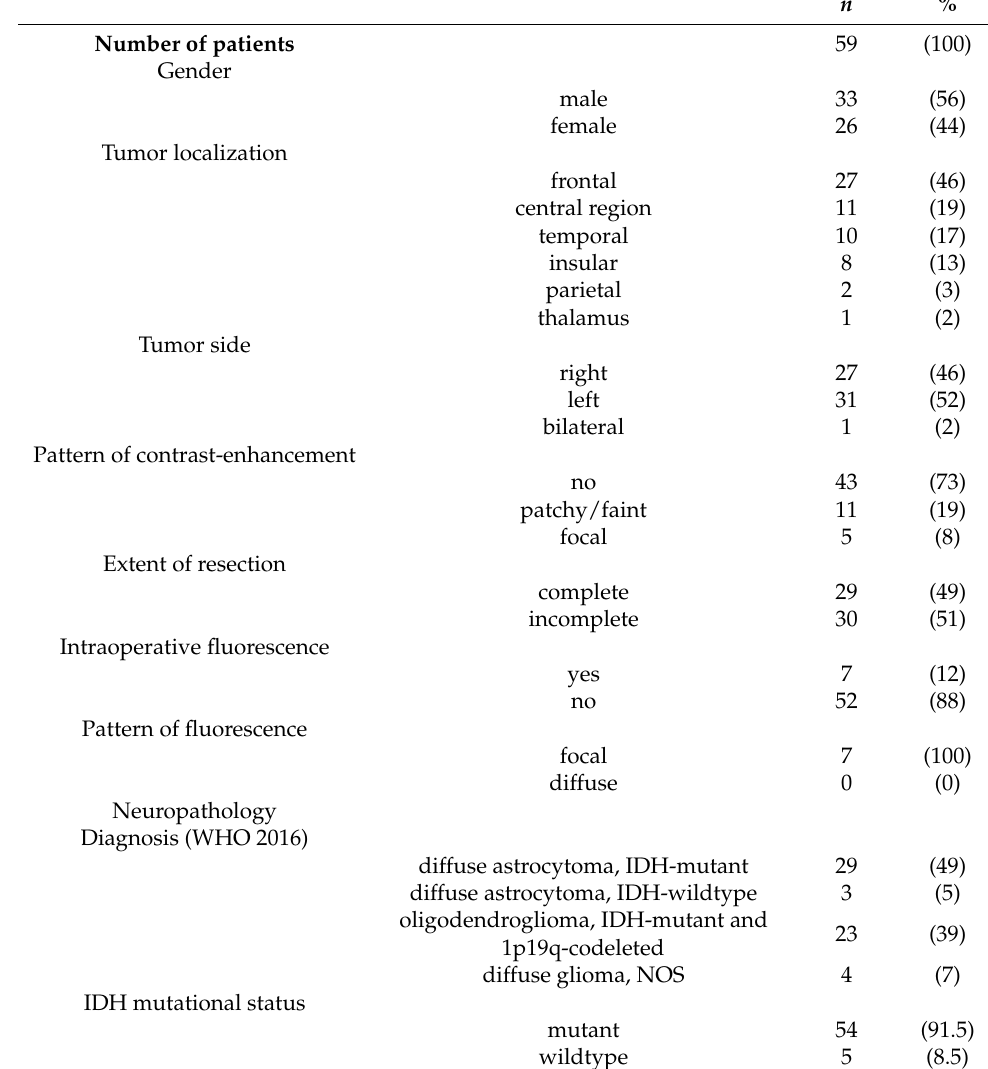
Table 1. Patients’